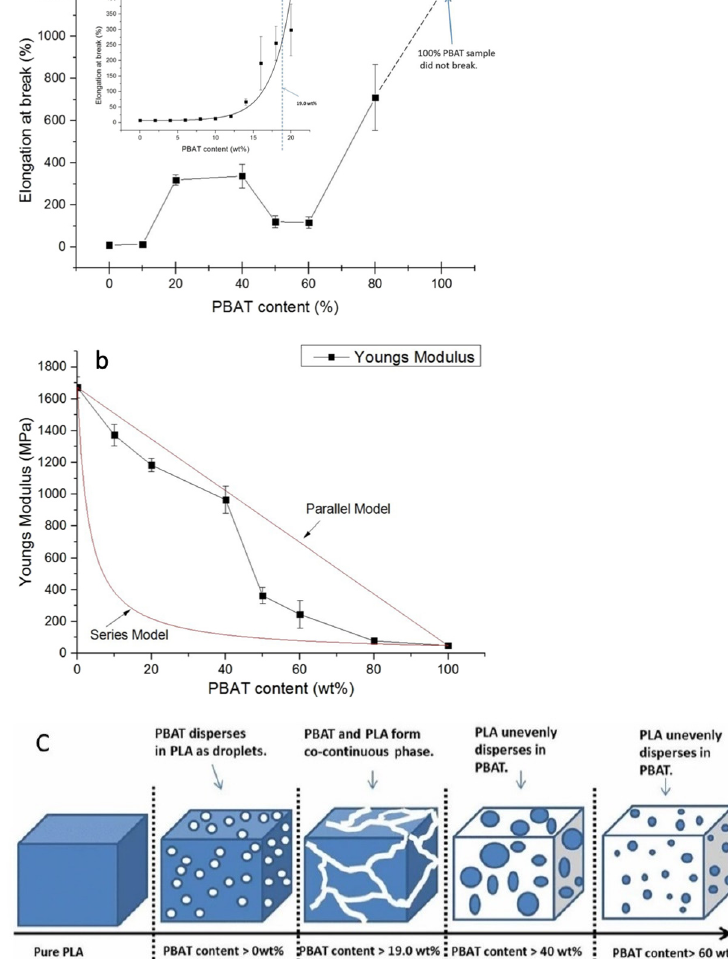
Figure 2. ( a ) Elongation at break, ( b ) Young’s modulus and ( c ) schematic representation of phase structure of PLA/PBAT blends as a function of composition. Reprinted (adapted) from Ref. [73].